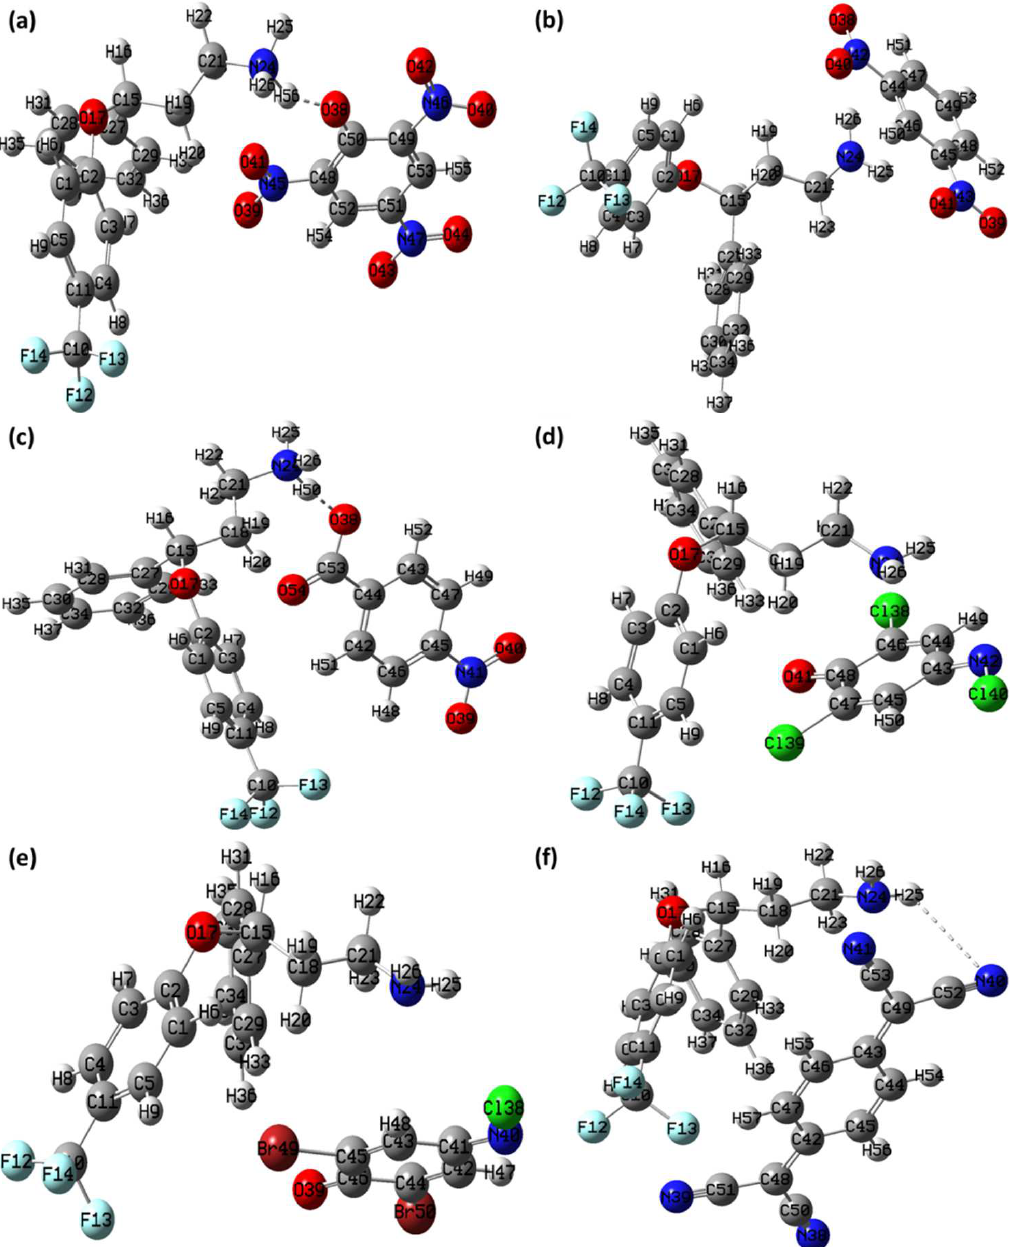
Figure 17. Optimized structure of ( a ) [(SRX)(PA}], ( b ) [(SRX)(DNB), ( c ) [(SRX)(p-NBA)], ( d ) [(SRX)(DCQ)], ( e ) [(SRX)(DBQ)], and ( f ) [(SRX)(TCNQ)] with Mulliken atom numbering scheme.